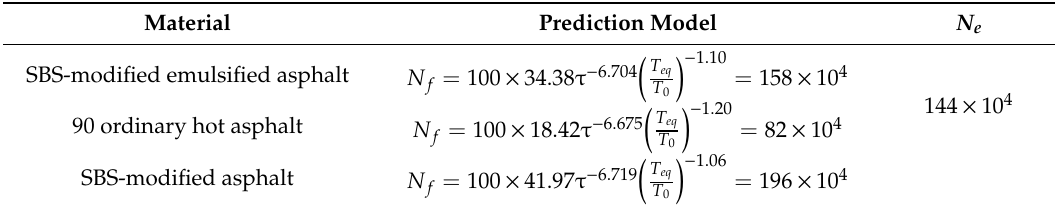
Table 16. Predicted shear fatigue life for di ff erent waterproof cohesive layer materials at 15 ◦ C (0.4 MPa interlayer shear